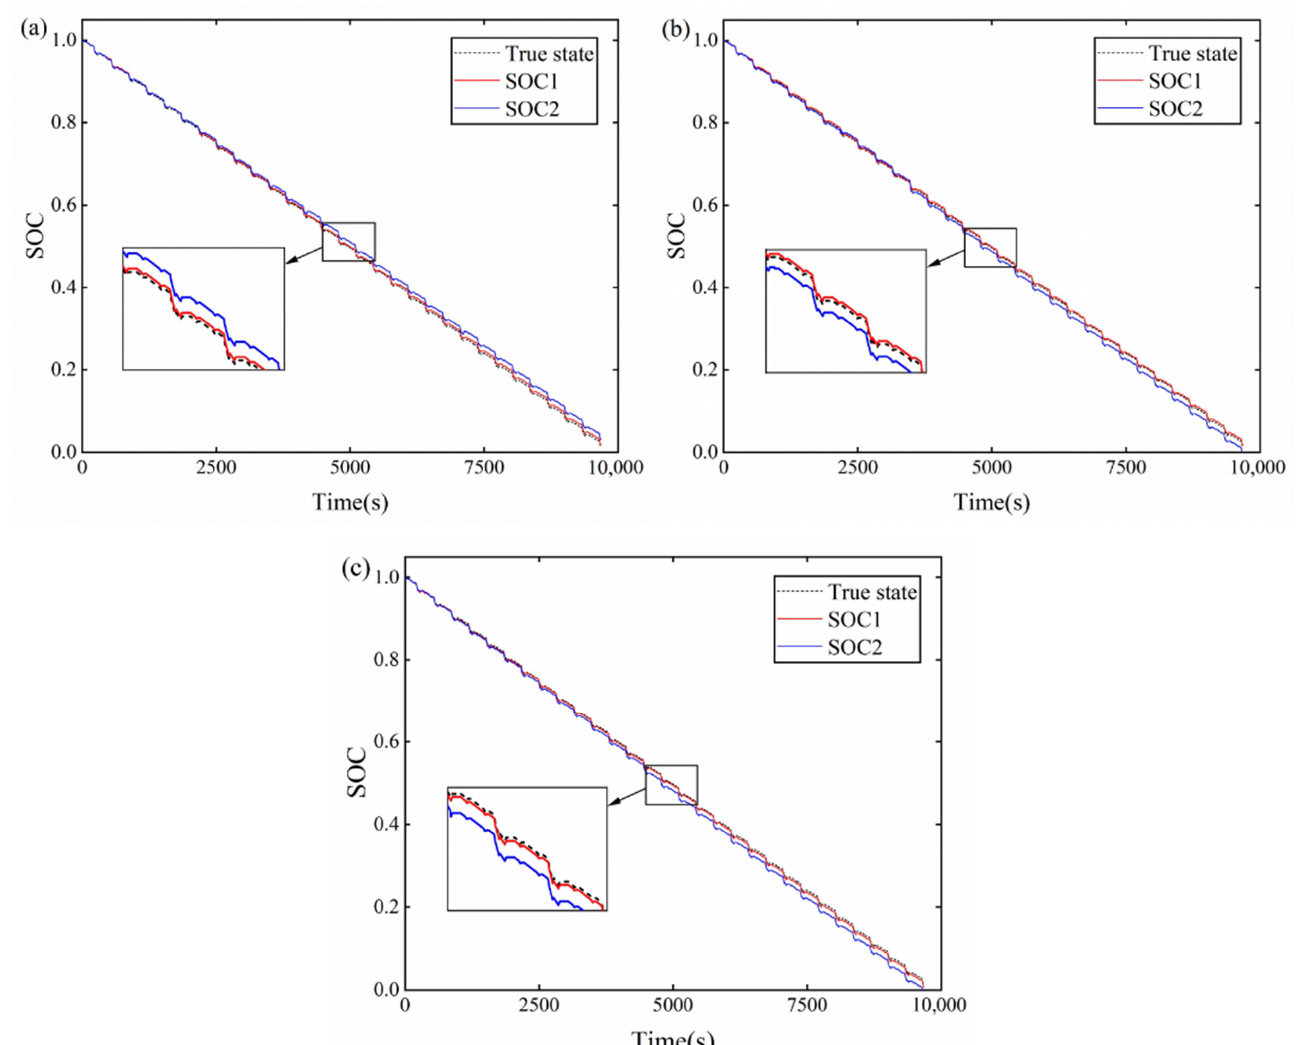
Figure 10. SOC estimation at ( a ) –20 °C; ( b ) 0 °C; ( c ) 30 °C.